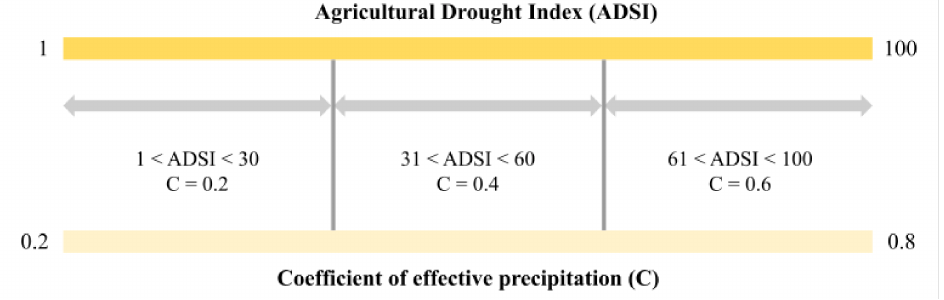
Figure 4. C reclassified depending on ADSI; C increases with an increased